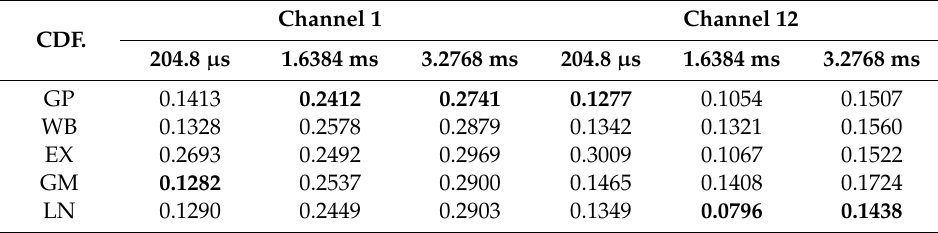
Table 4. KS distance for fitted distribution for di ff erent time resolutions.